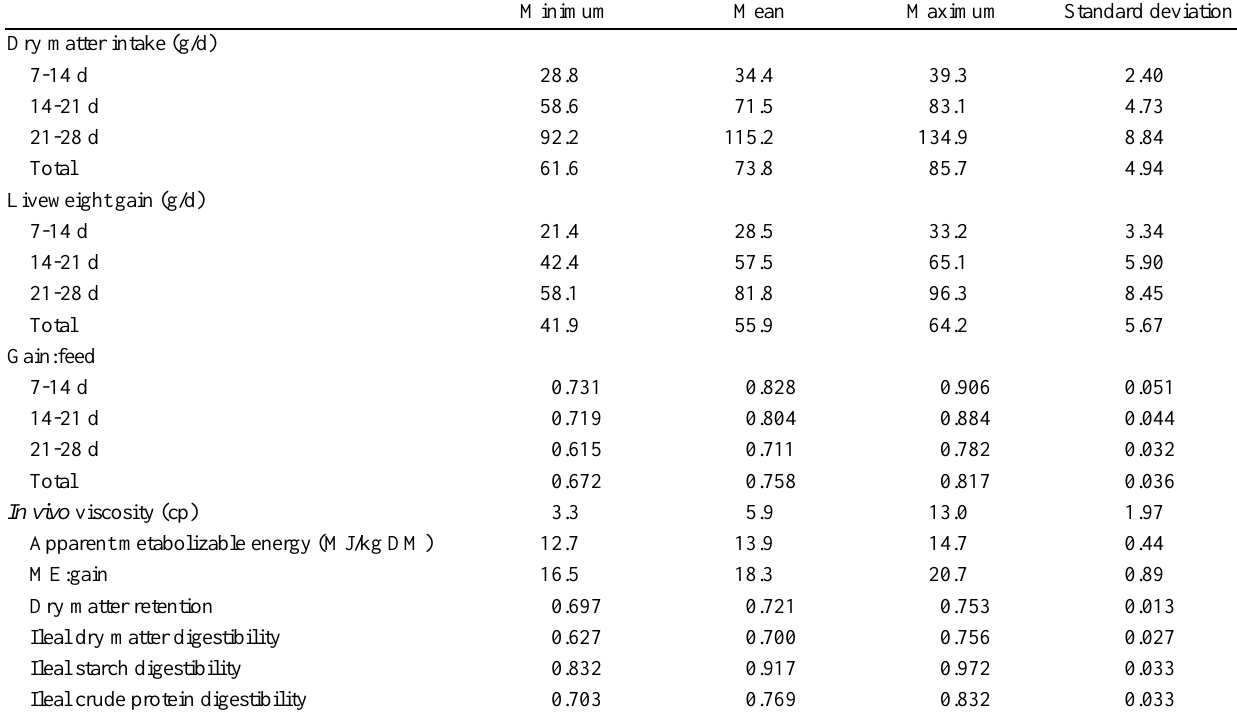
Table 3. The range and standard deviation in broiler performance and nutrient utilisation Minimum Mean Maximum Standard